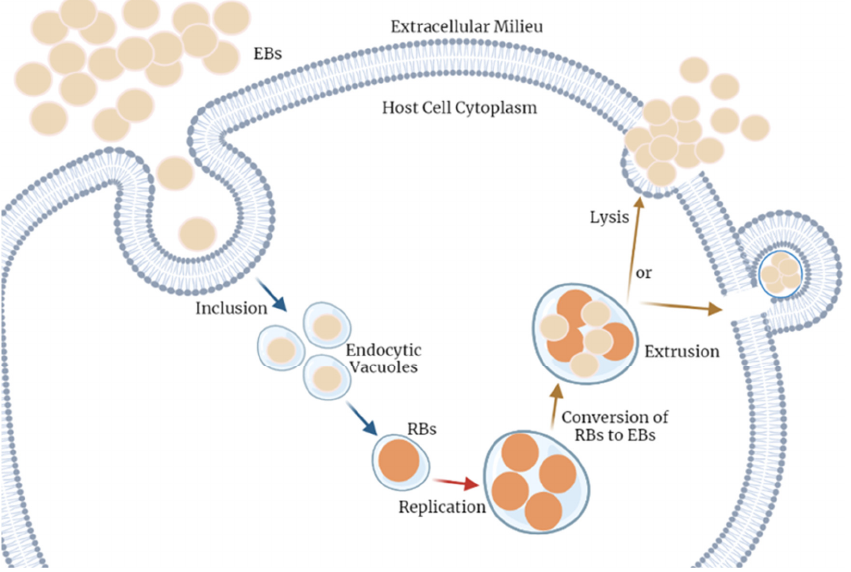
Figure 1. Chlamydia trachomatis cell cycle of infection. This pathogen alternates between two distinct forms. The infectious form, named elementary body (EB), when in contact with a host cell, can reach the cell cytoplasm by adhesion and internalization into a vacuole. Herein, EBs are converted into the alternative non-infectious form, the reticulate body (RB). These are capable of going through the replication process, using the host’s resources, and spending the cell’s energy and nutrients; concomitantly, it reaches a critical volume, thus, the RBs must transform into the previous form, EBs. Finally, there are two possible mechanisms for the extracellular EB release, (1) lysis of the host cell or (2) extrusion. This cycle occurs repeatedly in the adjacent cells. The Figure was created with BioRender.